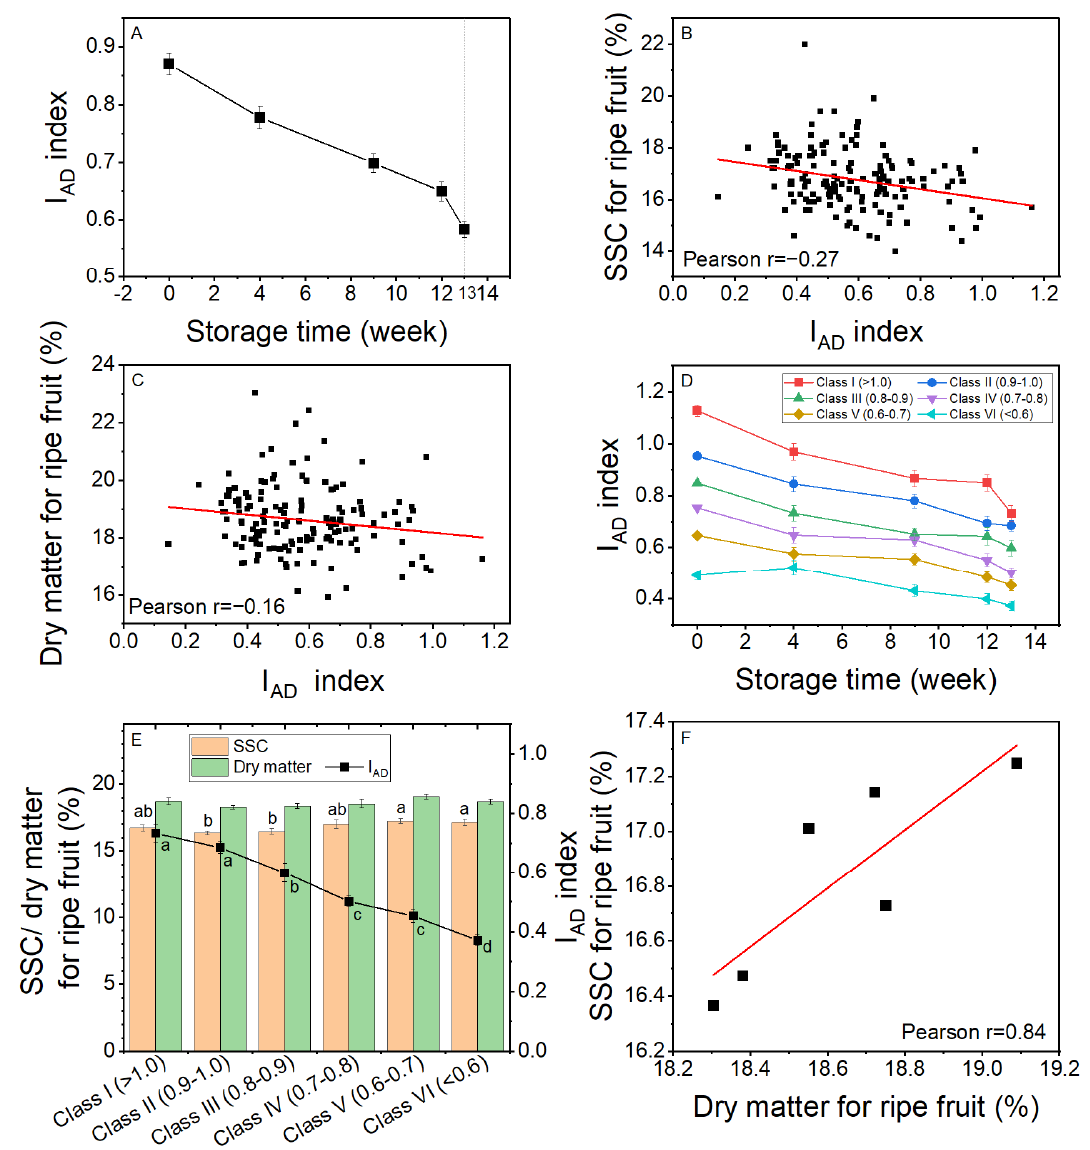
Figure 6. The change in the Kiwi-Meter I AD index value of Actinidia chinensis var. chinensis ‘Donghong’ fruit during storage at 0.5 ◦ C for 12 weeks and 7 days at 20 ◦ C and the association between I AD and ripe fruit soluble solids content (rSSC) and ripe fruit dry matter (rDM). ( A ) The change in I AD index with storage, n = 152 ± s.e.m. ( B ) The correlation between I AD and rSSC, n = 152. ( C ) The correlation between I AD and rDM, n = 152. ( D ) The change in I AD index during storage based on the I AD classification at harvest (Class I (>1.0)–Class VI (<0.6)), n = 20–32, ± s.e.m. ( E ) The I AD index,